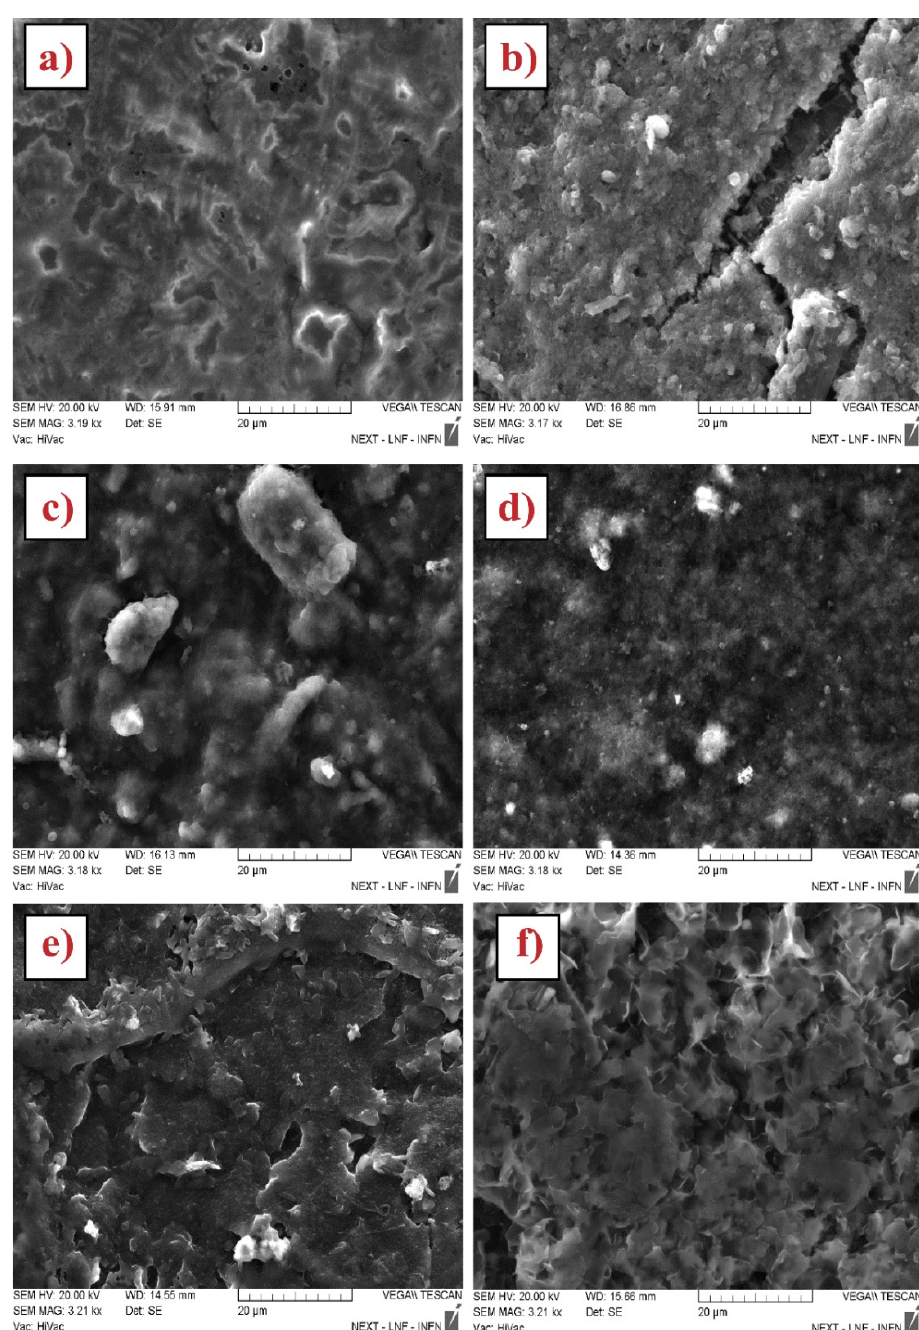
Figure 2. SEM characterization of uricase biosensors based on: ( a ) Bare SPE, ( b ) Bare MWNT, ( c ) CO 2 H-MWNT-SPE, ( d ) NH 2 -MWNT-SPE, ( e ) OH-MWNT, and ( f ) GNP-modified SPE.